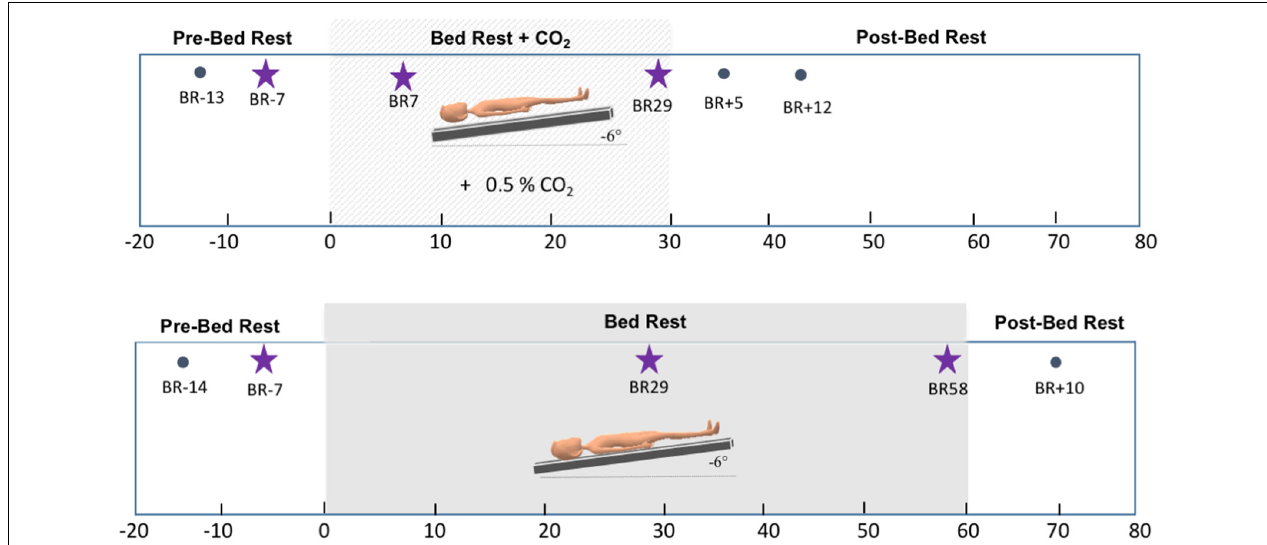
FIGURE 1 | Testing timelines. Top: testing timeline for the HDBR+CO 2 group. The lighter gray box corresponds to the intervention time, i.e., 30 days of head-down tilt bed rest (HDBR) with 0.5% atmospheric CO 2 . Bottom: testing timeline for the HDBR group. The darker gray box corresponds to the intervention time, i.e., 60 days of HDBR with normal atmospheric CO 2 levels. Stars indicate the three time points used to create the slope images for between-group comparisons.